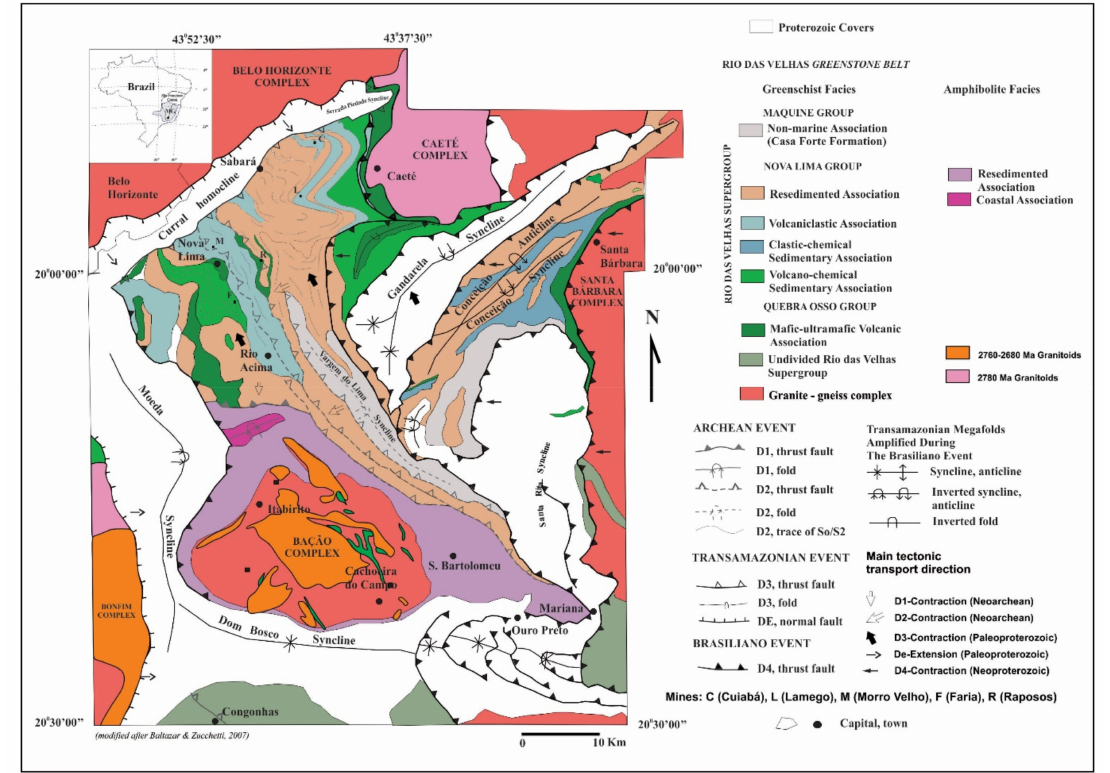
Figure 5. Simplified geological map of the Rio das Velhas greenstone belt with subdivisions and lithofacies associations (modified from [6]). Geology of the Baç ã o complex modified from